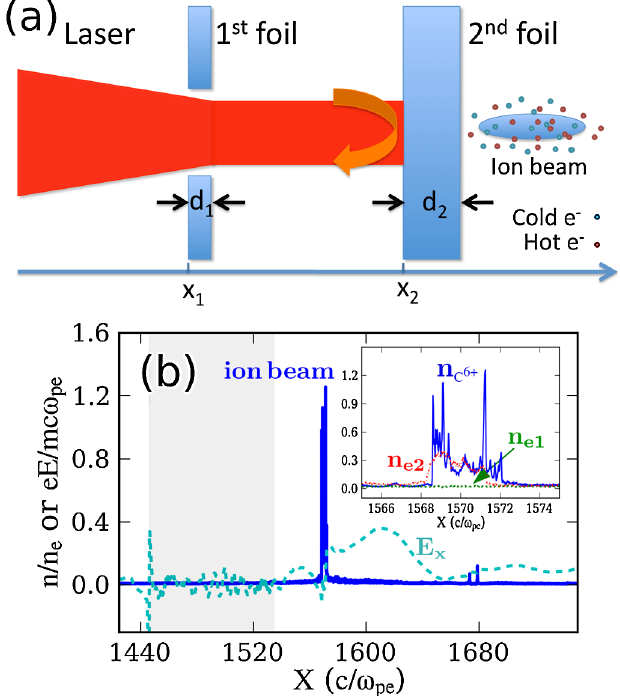
FIG. 2. (a) Diagram of the double-foil configuration. The laser is reflected at the second foil while the ion beam comoves with electrons of two-temperature components. (b) 1D PIC simulation with the second foil (shaded region) of thickness d 2 ¼ 0 : 5 (cid:4) m and placed at x 2 ¼ 9 (cid:4) m ¼ 1452 c=! pe (laser field/first foil not shown). The TNSA sheath field (dashed, light blue) is detached from the second foil and comoves with the ions (solid, blue) which is spatially localized at x ¼ 1570 c=! pe with a width d 0 (cid:1) 4 c=! < d t ¼ 156 fs . The inset also shows pe 1 (see inset) at the comoving electrons from the first foil (dashed, green)/second foil (dotted,